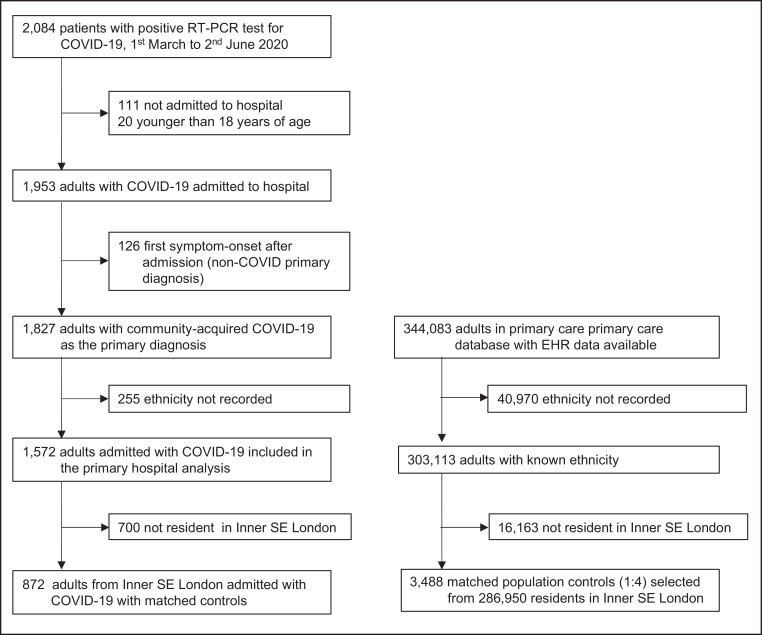
Study flow chart.